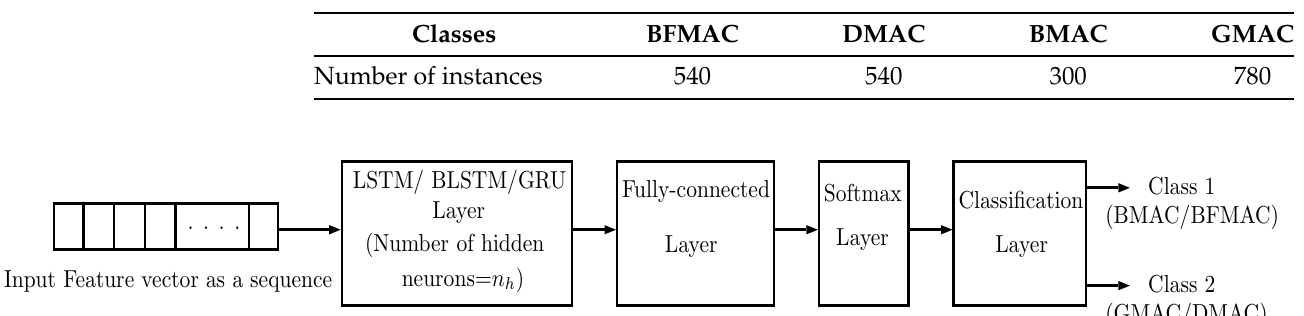
Table 1. Number of multi-channel EEG instances used in this work.